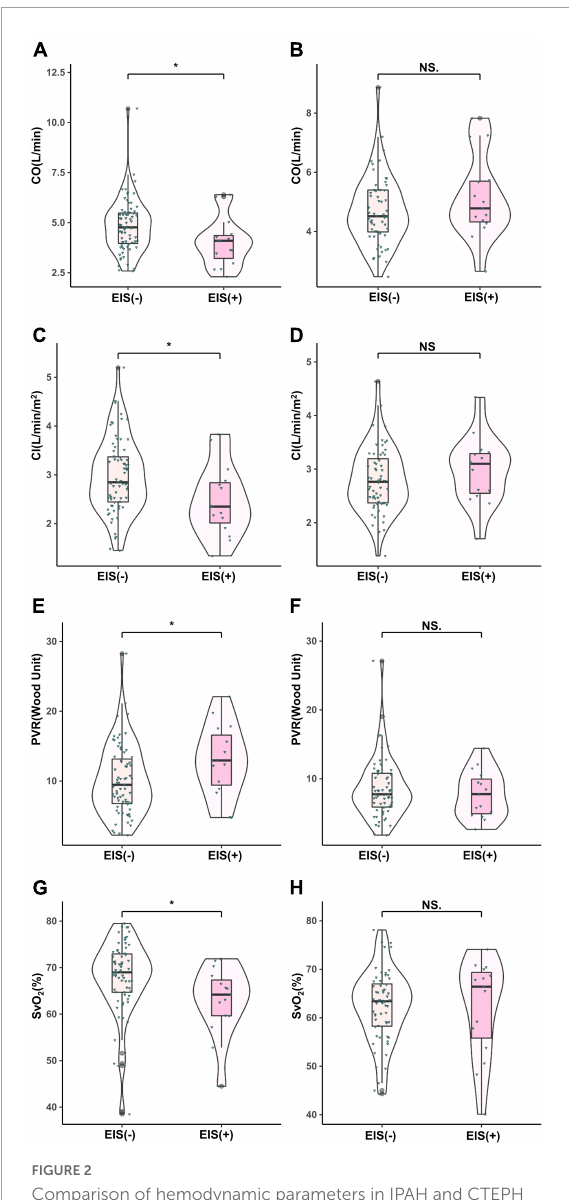
FIGURE3 Comparison of echocardiographic parameters in IPAH (A,C,E,F) and CTEPH (B,D,G,H) patients stratified by EIS ( + ). ** P < 0.01, *** P < 0.001. IPAH, idiopathic pulmonary arterial hypertension; CTEPH, chronic thromboembolic pulmonary hypertension; EIS, exercise-induced right-to-left shunt; RVEDTD, right ventricular end-diastolic transverse diameter; TAPSE, tricuspid annular plane systolic excursion; VCO 2 , carbon dioxide output; VE, minute ventilation; VO 2 , oxygen